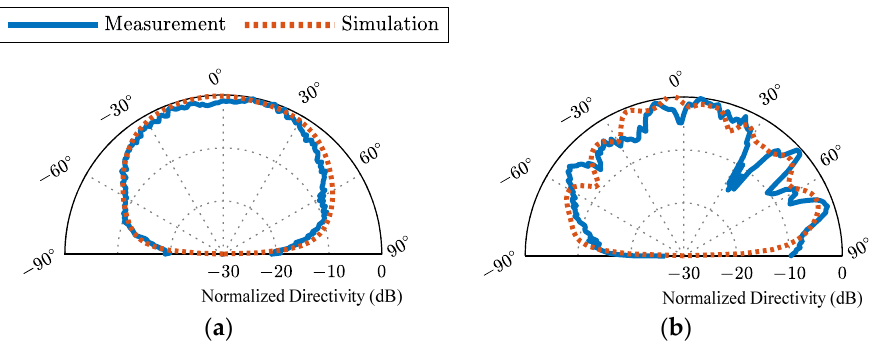
Figure 15. Radiation pattern measurements ( a ) xz -plane; ( b ) yz -plane.